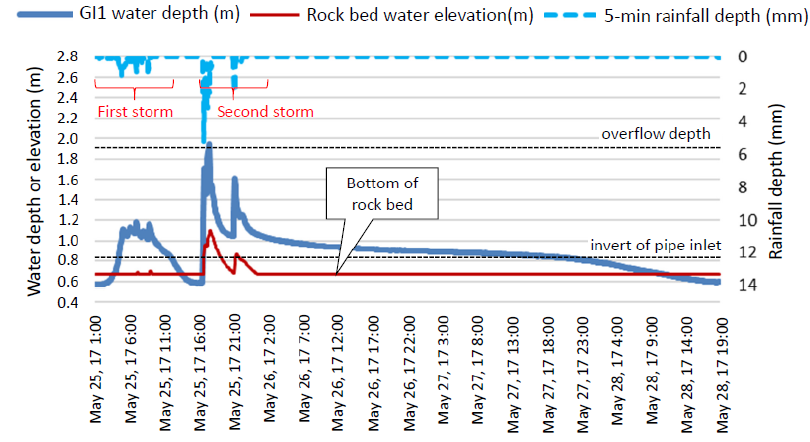
Figure 5. Rainfall depth and water depth (inlet structure and rock bed, with the bottom of the inlet structure as the datum) from events without (first storm) and with (second storm) partial clogging on 25 May 2017.